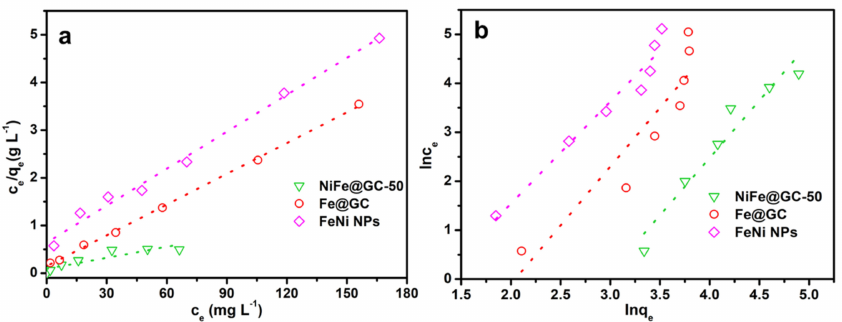
Figure 6. ( a ) Linear Langmuir and ( b ) Freundlich plot for the removal of TCP. (Experimental conditions: pH = 3.0, dosage = 1.0 g L − 1 , T = 298.15